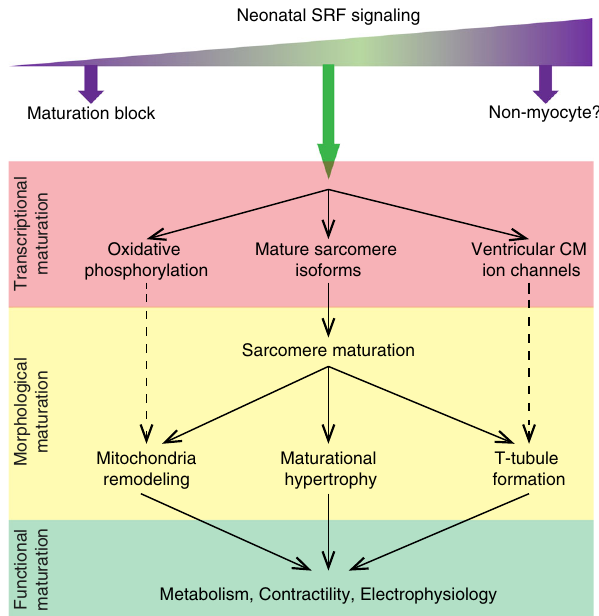
Fig. 9 Schematic summary of SRF regulation of CM maturation. A balanced level of SRF activity is required in maturing CMs for the transcription of major genes that are required for CM maturation. These genes